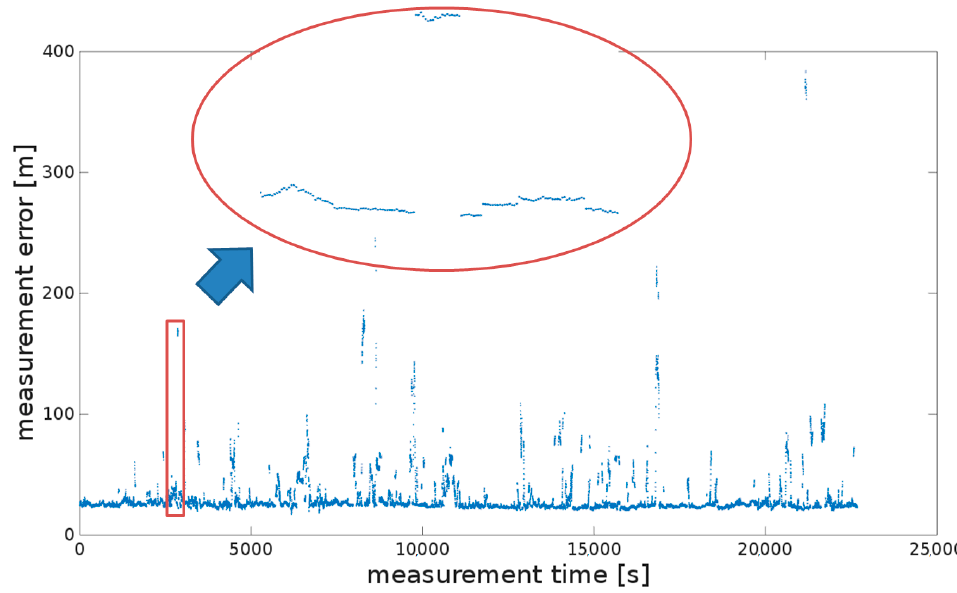
Figure 9. GNSS position accuracy records for the static measurements. Table 5. Standard error and percentile evaluation of position processing using the proposed new